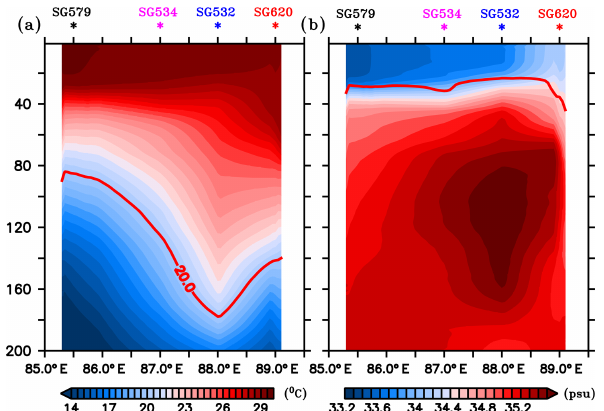
Figure 2. Depth–longitude sections of (a) temperature ( ◦ C) and (b) salinity (psu) obtained from ocean gliders averaged for 3– 14 July, the common period when all the gliders performed data sampling. Mean glider locations are marked at the top of each panel. Red curves in (a) and (b) represent the thermocline and MLD re- spectively. The thermocline is represented by the 20 ◦ C isotherm (D20). MLD is calculated as the depth where density is equal to the sea surface density plus an increase in density equivalent to a reduction in temperature of 0.8 ◦ C.